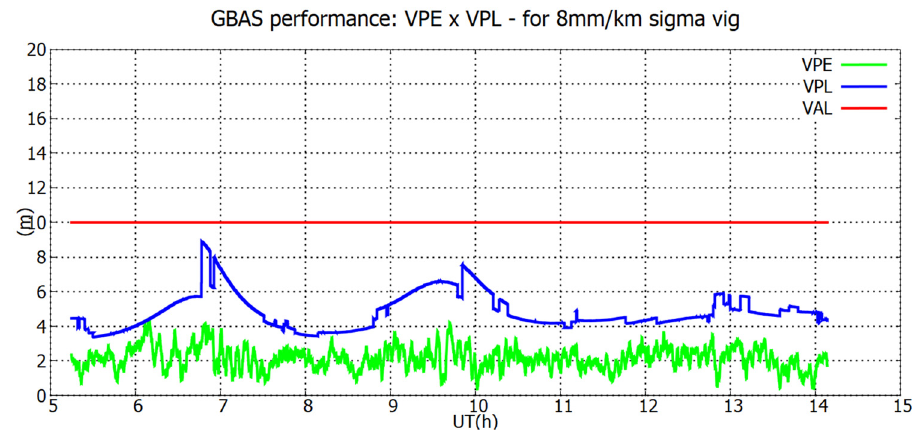
Figure 11: Performance of positioning errors and protection levels for GBAS simulation considering σ vig of 8